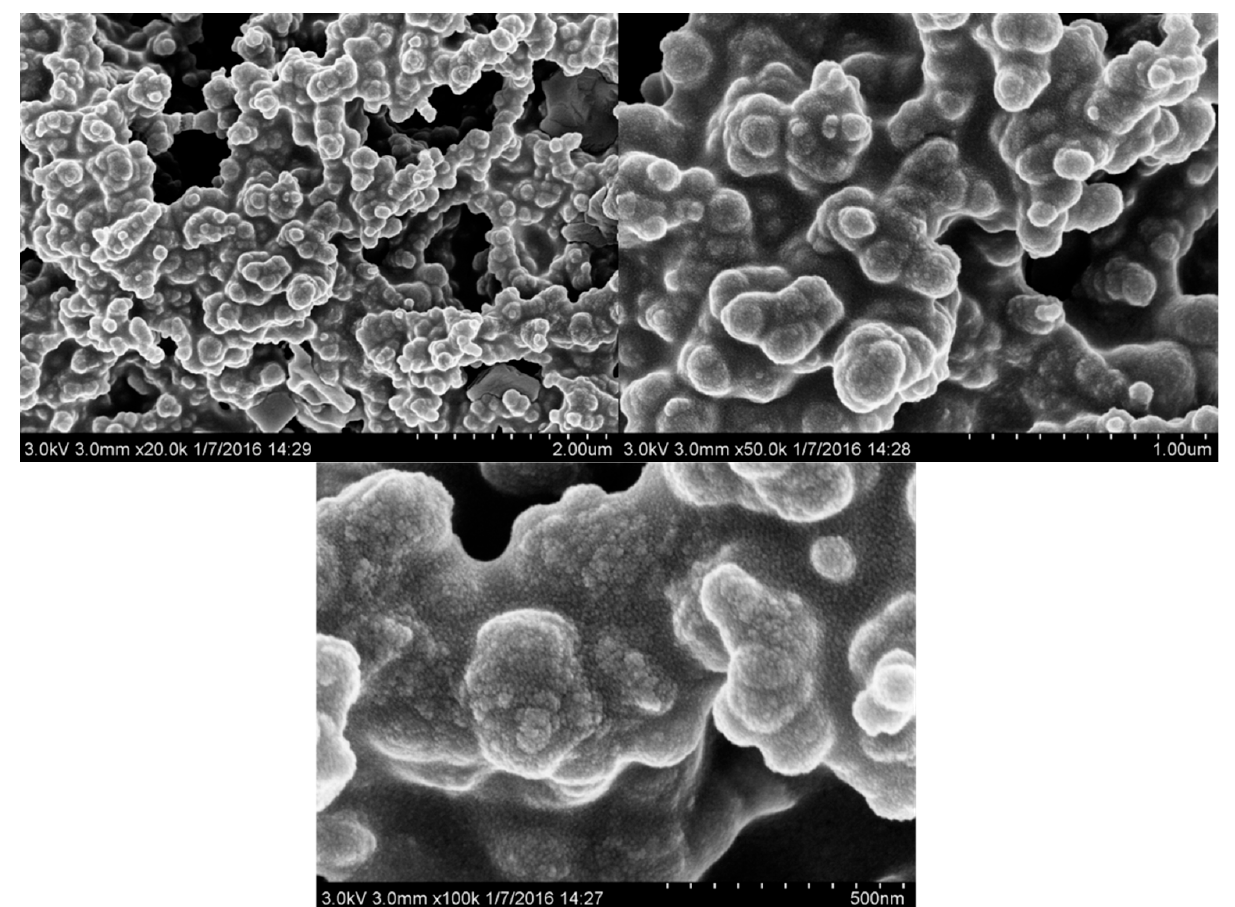
Figure 3. Representative SEM images of series of PANI nanocomposites (( A ) Sample 4; ( B,C ) Sam- ple 1).